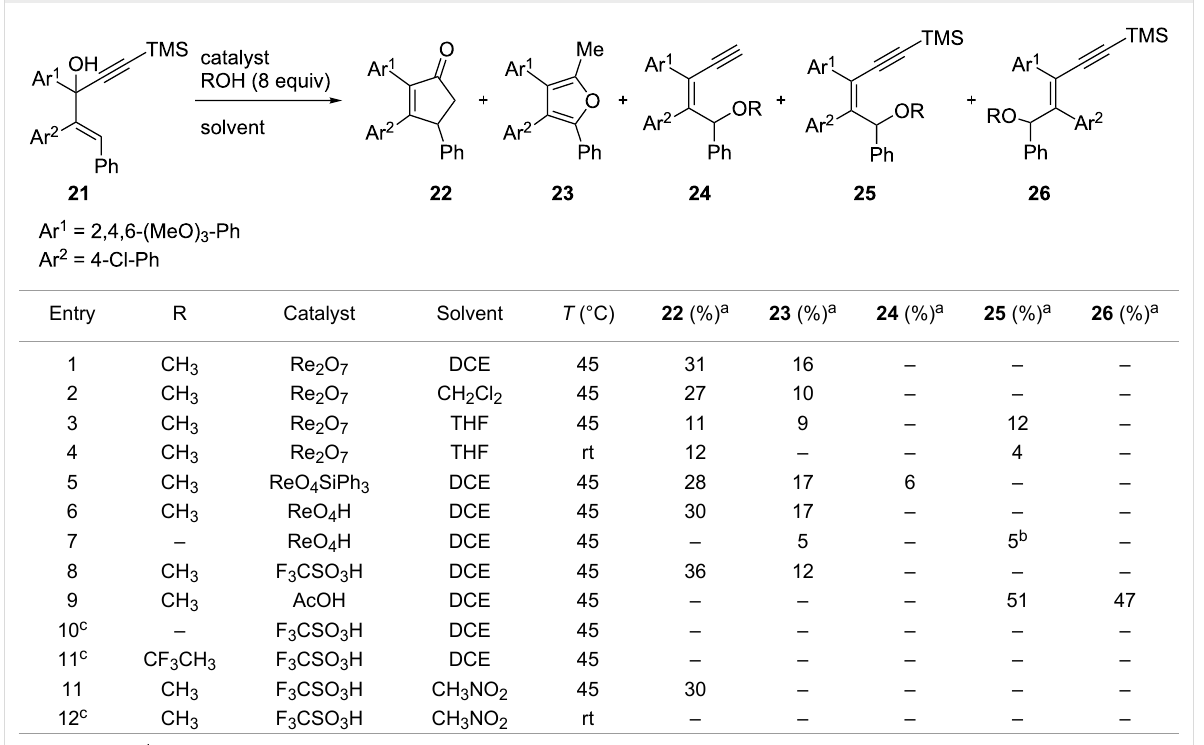
Table 2: Optimization of the acid-catalyzed rearrangements of enynol 2